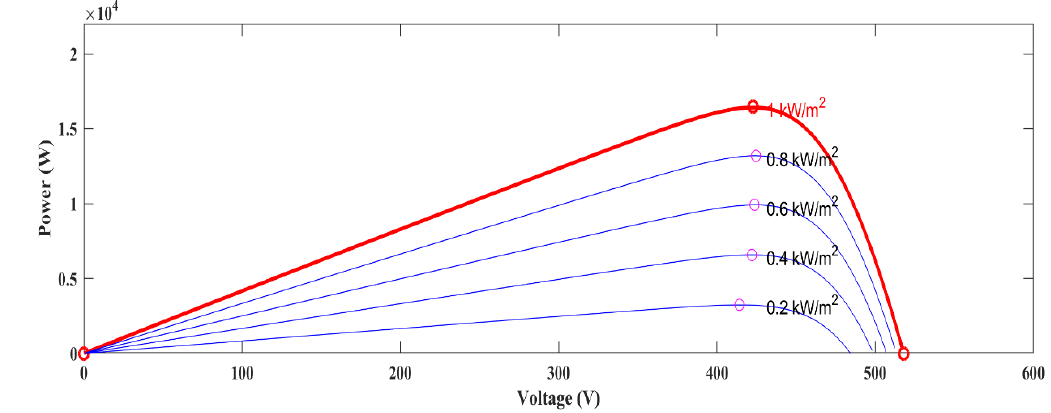
Figure 17. PV Module P-V Characteristics.